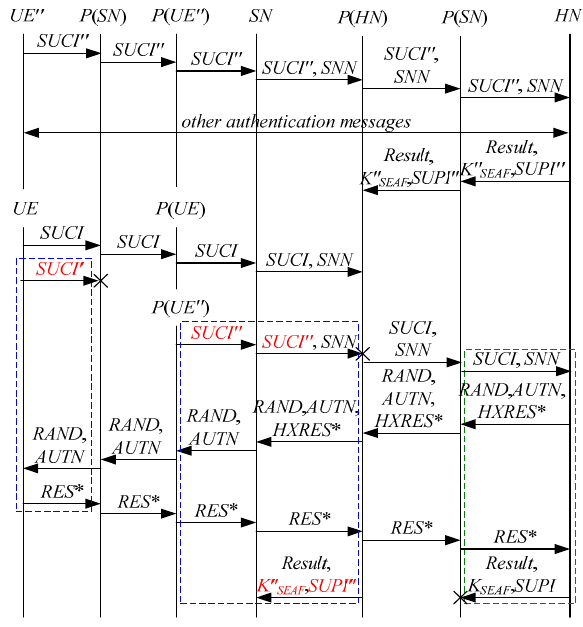
Figure 12. The eleventh attack scenario of the 5G AKA protocol. In Figure 12, the green dashed box represents the server strand of Theorem 4, while the blue dashed boxes represent the initiator strand and the responder strand of Theorem 4. The fields marked in red on the initiator strand and the responder strand are some fields that cannot be agreed with the HN, which are caused by MitM attacks.